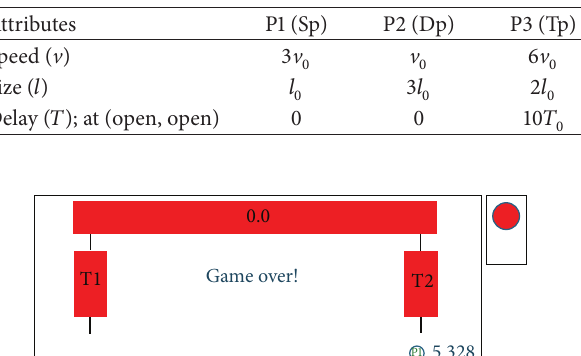
Table 4: Players’ attributes resulting with NE destabilization.